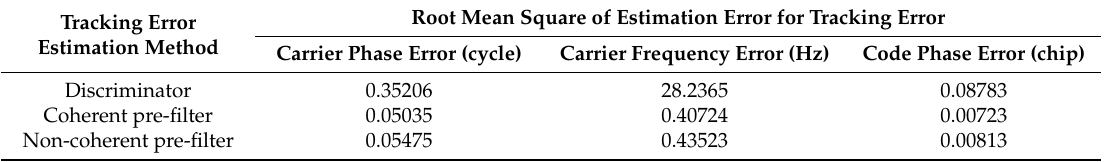
Table 3. Performance comparison of tracking error estimation methods in test scene